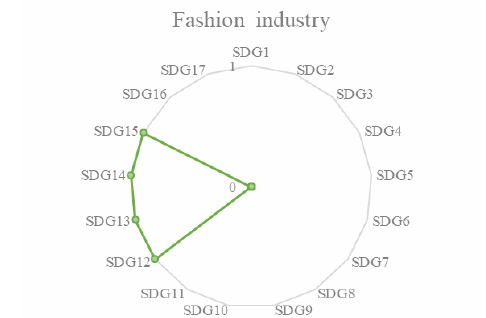
Figure 4. Social Entrepreneurship cluster of application effect on SDGs.